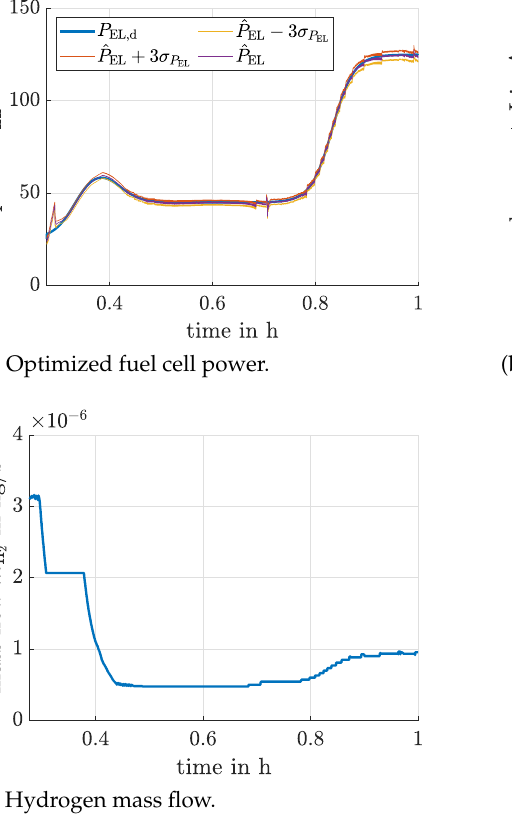
Figure 15. Input optimization for the static neural network system model with n = 3 for smooth changes of the desired electric power. Table 5. Comparison of the tracking behavior of the proposed input optimization scheme for various system models and different types of reference signals for the desired electric